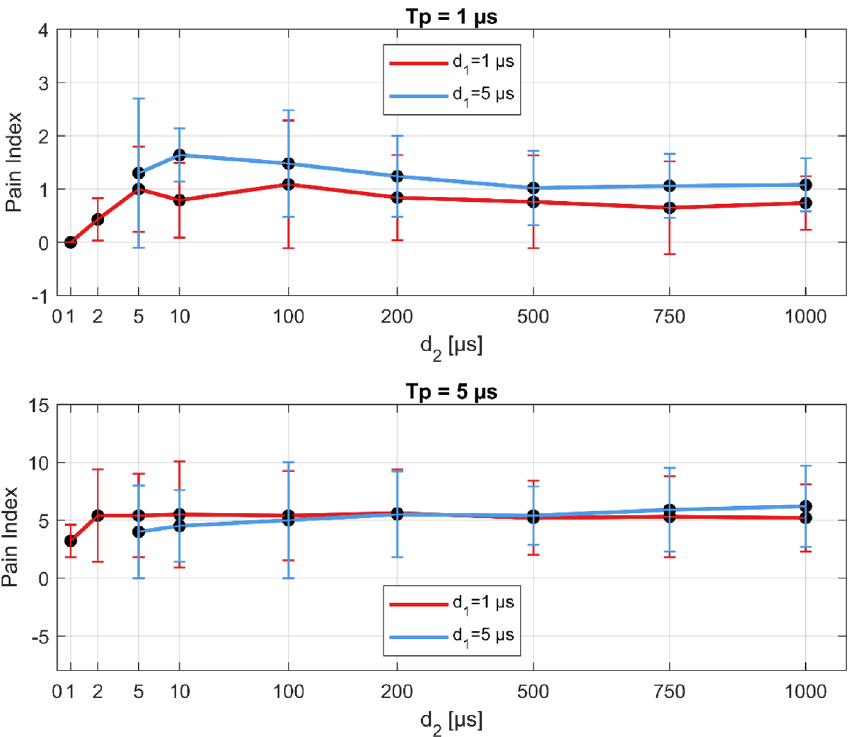
Figure 5. Longer interpulse delays slightly increase the pain index for longer pulse widths (lower figure). Upper figure: 400 × 1 µs pulses, lower figure: 80 × 5 µs pulses. Note different ordinate scales (higher pain indexes for T p = 5 µs). The results are shown as the mean (black dots) ± standard error (vertical bars). T p -pulse width, d 1 - interphase delay, d 2 -interpulse